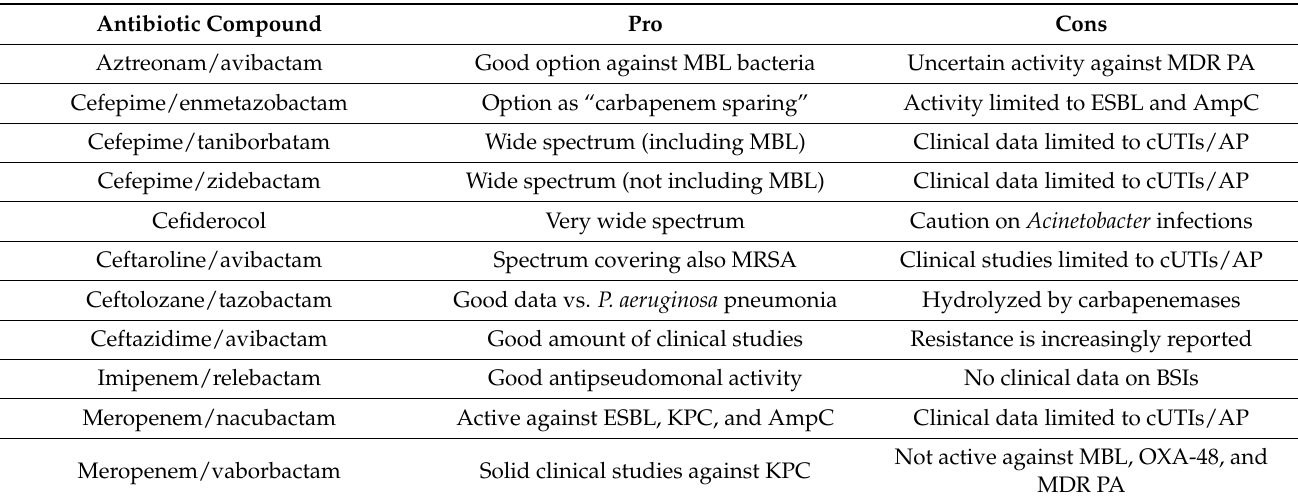
Table 5. Pro and cons of new antibiotic